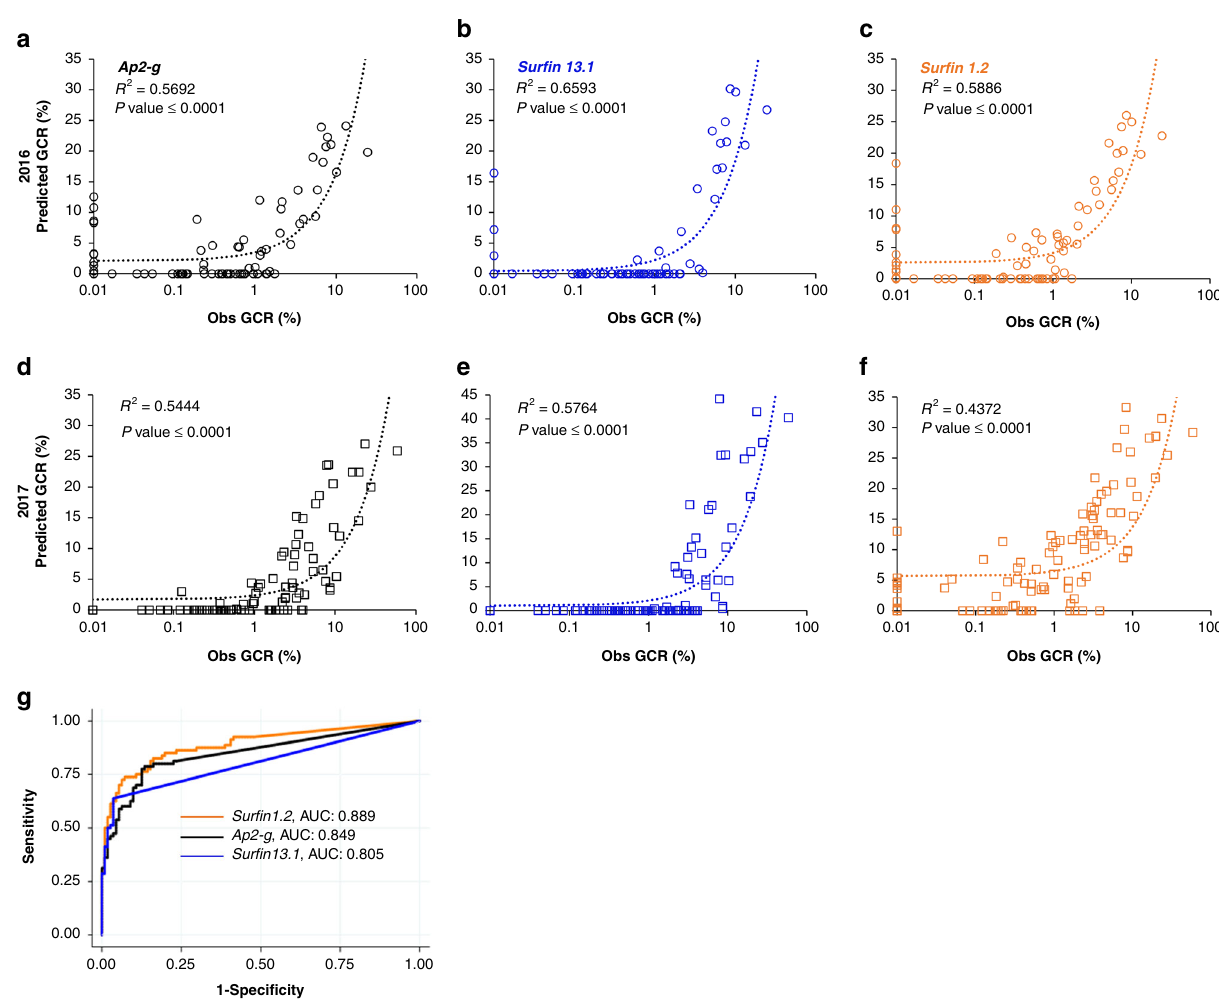
Fig. 5 Correlation between predicted GCR and ex vivo observed GCR. The observed (Obs) gametocyte-conversion rate (GCR) was determined microscopically in the day (D)8 ex vivo cultures and the predicted gametocyte-conversion rate (GCR) was calculated for each gametocyte-committed (gc)-ring biomarker ( ap2-g (black), sur fi n 13.1 (blue), and sur fi n 1.2 (orange)) in biologically independent D0 patient samples (2016 ( n = 81, circle, a – c ) and 2017 ( n = 110, square, d – f )) using the trend line equations from Fig. 4d – f. Pearson ’ s correlation coef fi cient (R) 2 and the corresponding P value (two-sided) are indicated. g Receiver-operating characteristics curve (ROC) analysis using samples from the 2 study years ( n = 191 independent patient samples). Source data are provided as a Source Data fi le.